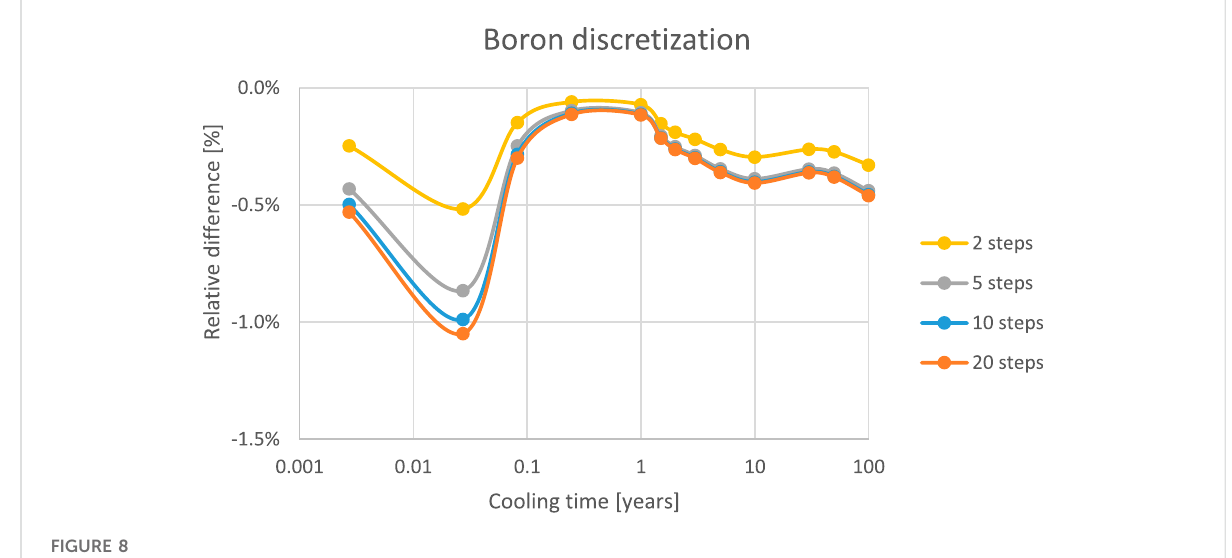
Effect of the soluble boron discretization on the decay heat.